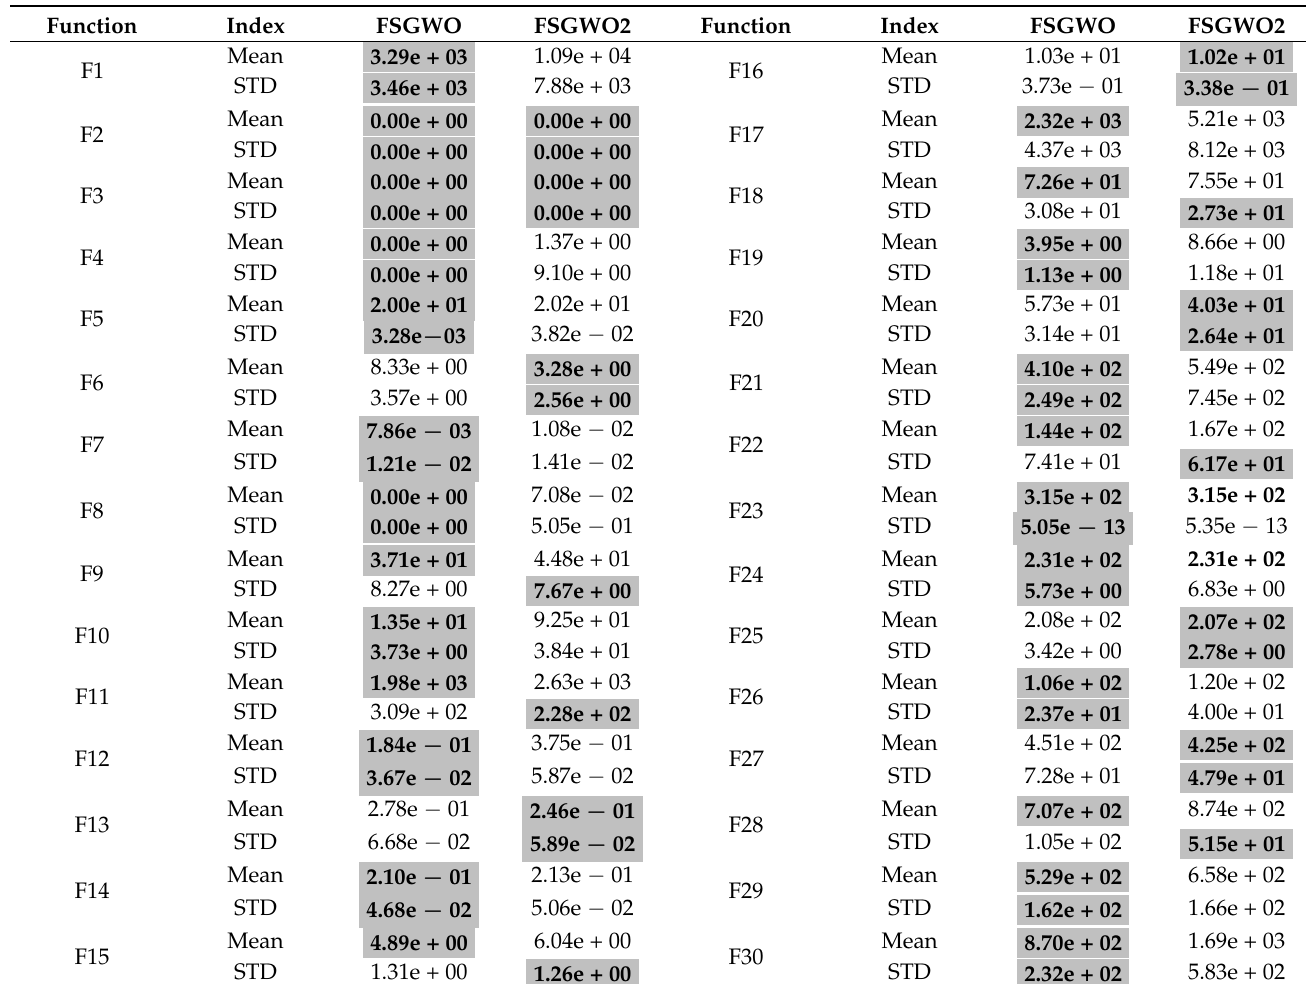
Table 10. Results of FSGWO and FSGWO2 for 30-dimensional functions.